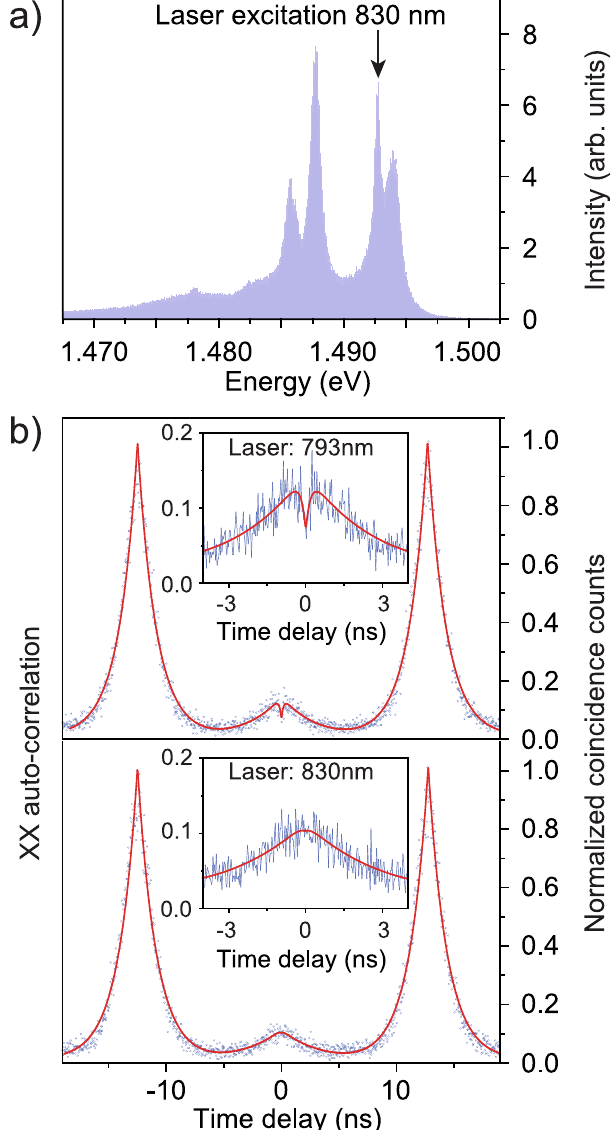
Figure 4. ( a ) Photoluminescence spectrum of the wurtzite InP nanowire resonances. The sharp resonance at 830 nm was addressed with a ps-pulse laser to excite the quantum dot quasi-resonantly. ( b ) Auto-correlation histograms (time bins 32 ps) of the biexciton for above-band excitation at 793 nm (top) and quasi-resonant excitation in the InP nanowire wurtzite resonance at 830 nm (bottom). As shown in the insets the volcano- shaped dip at zero time delay, characteristic for reexcitation processes, is significantly reduced for the quasi- resonant excitation scheme in the lower